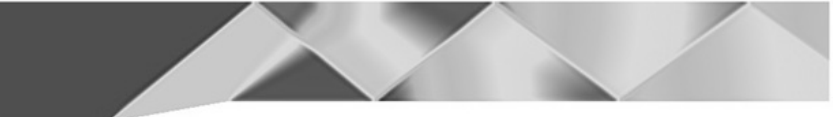
Figure 5. Mach number, supersonic flow in channel with a wedge.